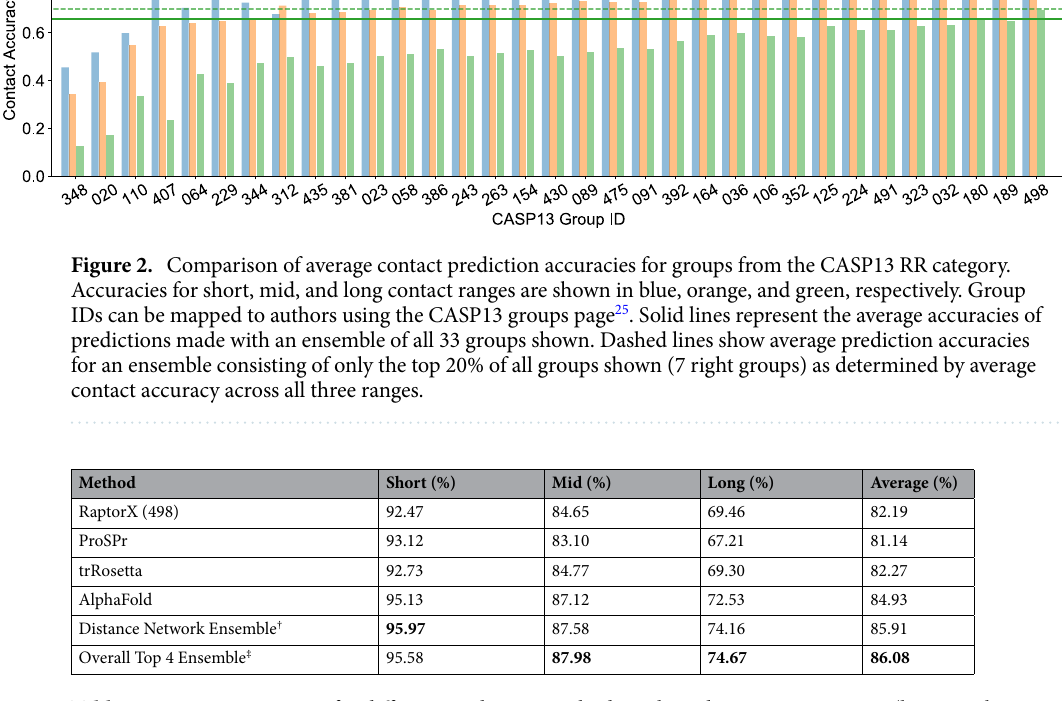
Table 1. Contact accuracies for different prediction methods evaluated on CASP13 test set (largest column value in bold). † Combines ProSPr, trRosetta, and AlphaFold predictions. ‡ Combines predictions from ProSPr, trRosetta, AlphaFold, and CASP13 winner RaptorX (group 498).